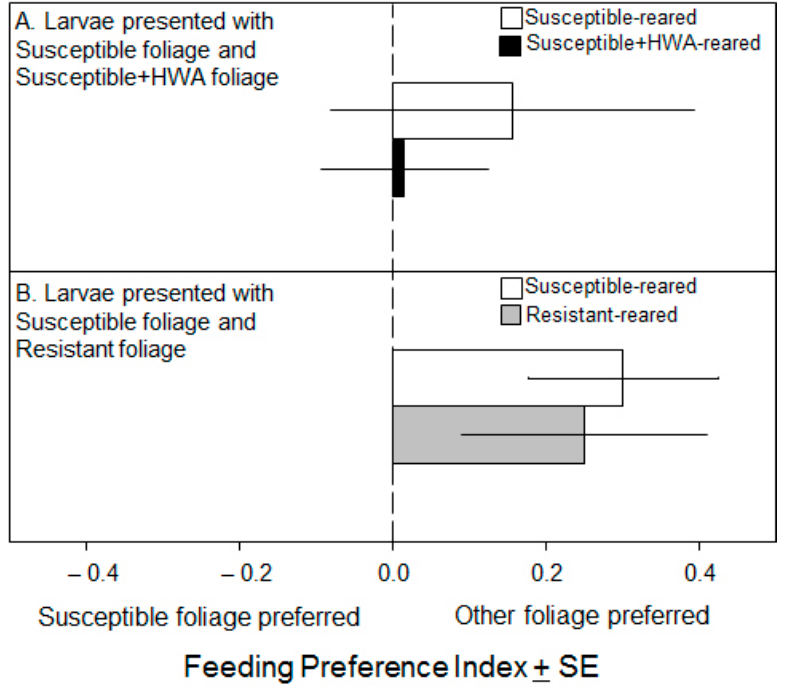
Figure 3. ( A ) Feeding preference index ( − 1: only ate Susceptible foliage; 0: no preference; 1: only ate other foliage type) of larvae reared on Susceptible (white bars; n = 7) or Susceptible + HWA (black bars; n = 6) natal foliage; and ( B ) Susceptible (white bars; n = 17) or Resistant (gray bars; n = 19) natal foliage.